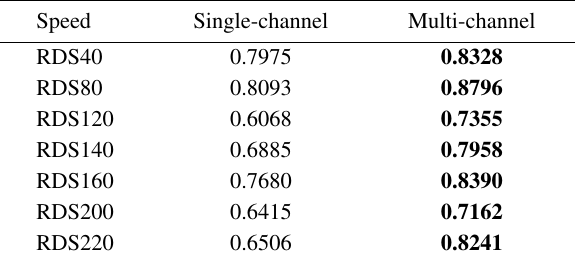
Fig. 6 FCC of WvKFCM with different numbers of multi- channel. Table 2 FCC of RDS with single-channel and multi- channels.